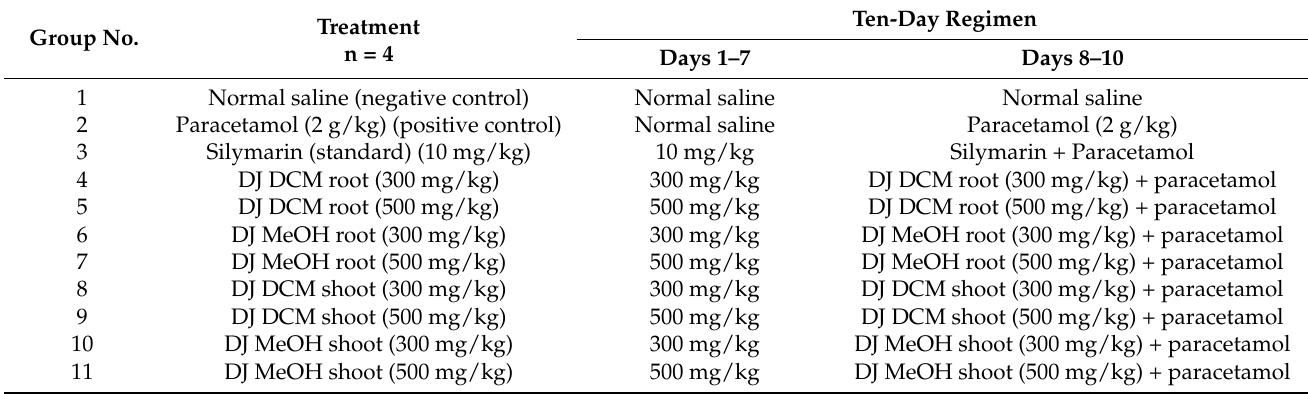
Table 1. Hepatoprotective activity of DJ crude extracts.